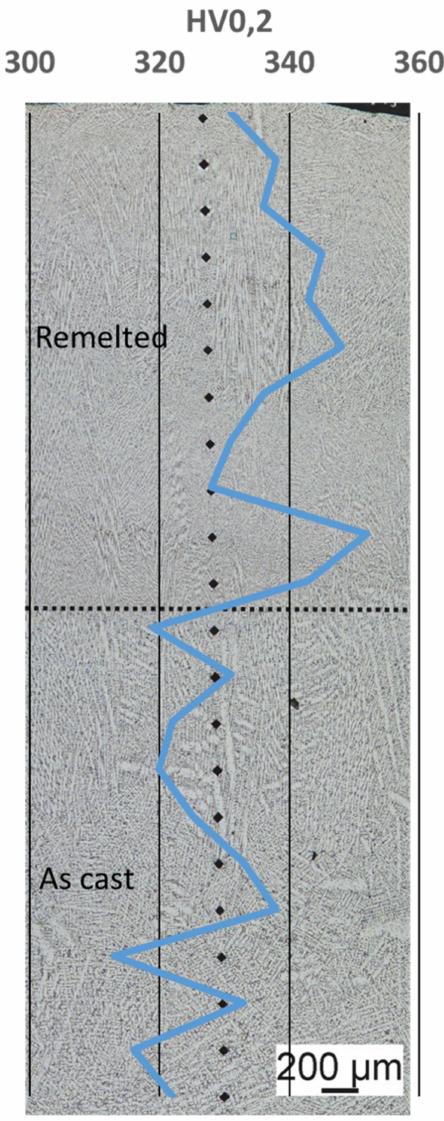
Figure 7. Hardnessprofile of re-melted alloy and base